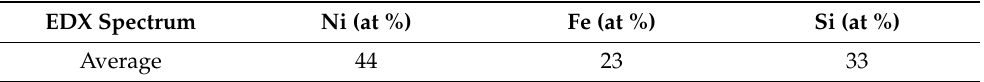
Table 1. Atomic percentage of Ni, Fe and Si elemental composition in Ni 2 FeSi glass- coated